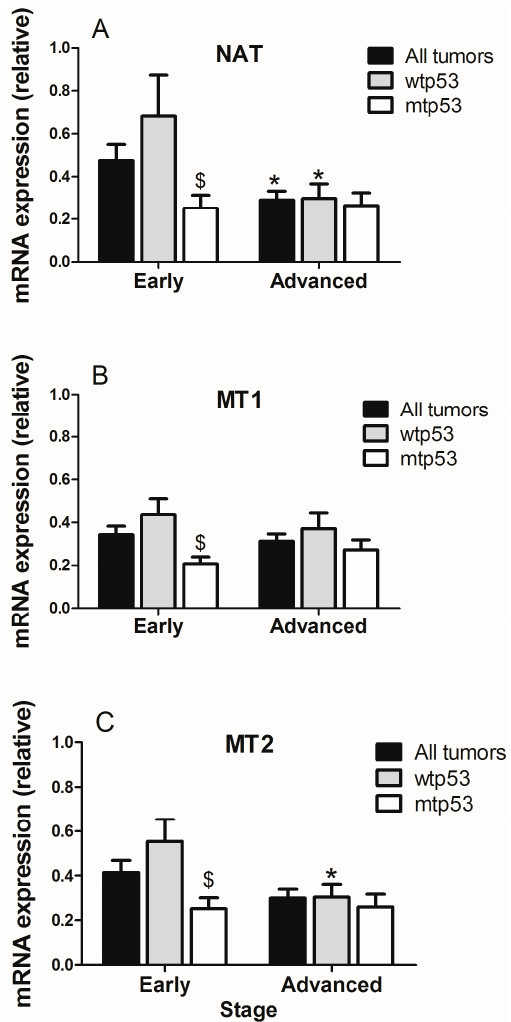
Figure 2. Expression of ( A ) AA-NAT; ( B ) MT1 and ( C ) MT2 in early stages (stage I + stage II) versus advanced (stage III + stage IV) colorectal tumors considering the status of p53. Data represent mean ± S.E.M. * p < 0.05 versus early; $ p < 0.05 versus wtp53.